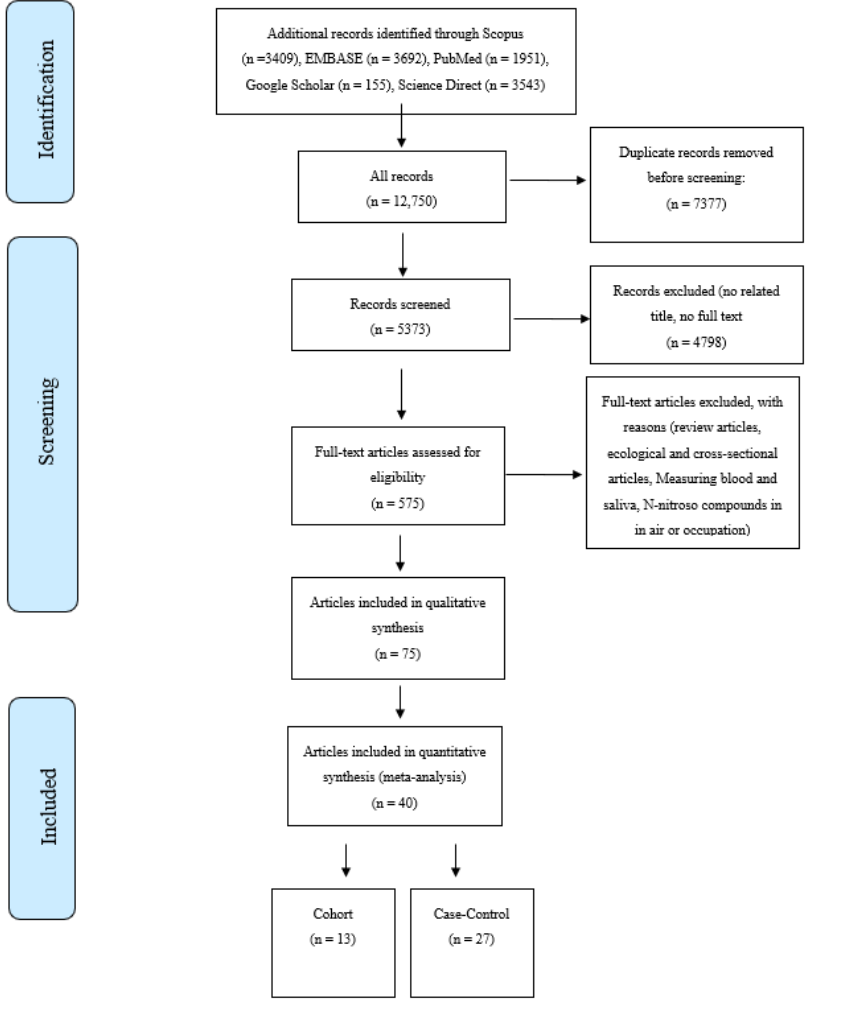
Figure 1. Selection process for studies included in the meta ‐ analysis for the intake of nitrate, nitrite, and N ‐ nitroso compounds from diet and water and the risk of gastrointestinal